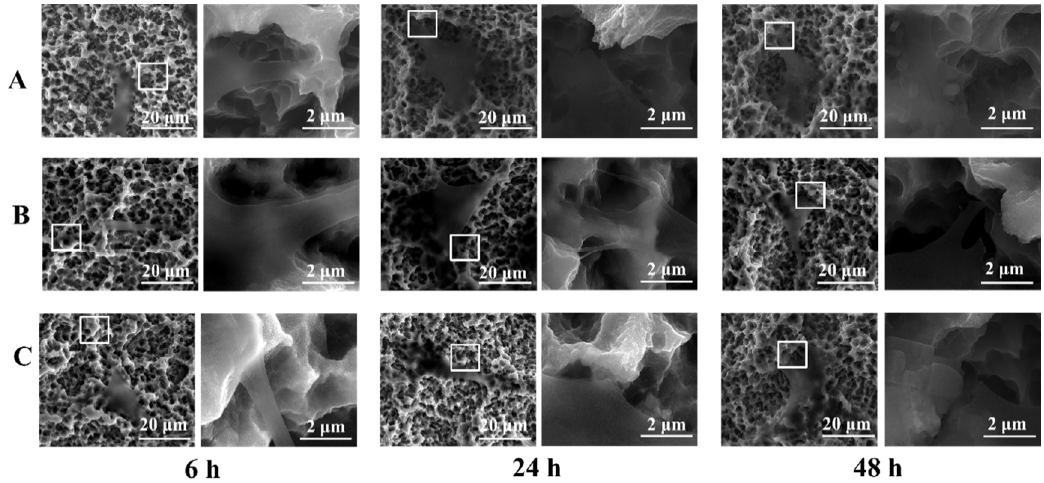
Figure 5. Adhesion and spread of cells on the sample surface after cell culture for 6, 24 and 48 h: ( A ) SLA, ( B ) oxidation, ( C ) storage.